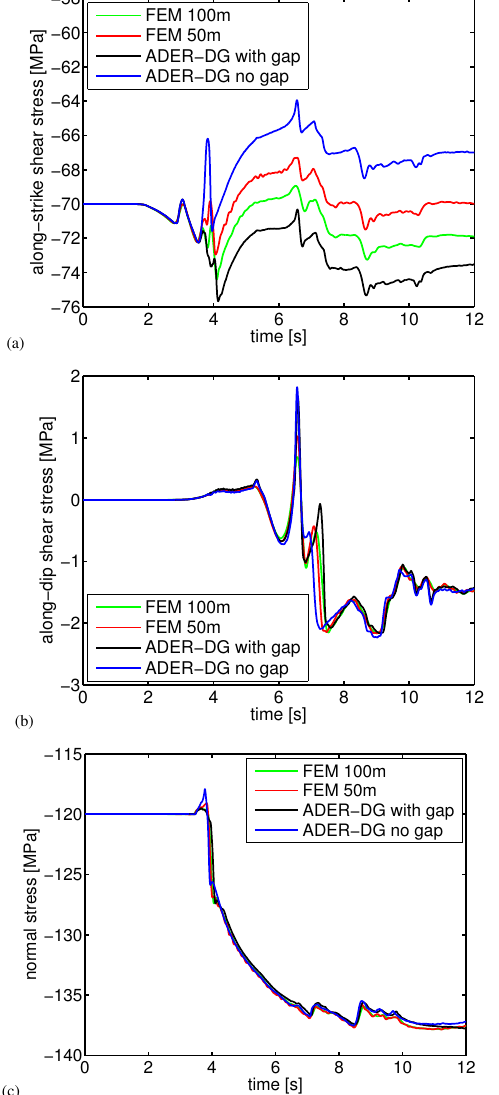
Table 4. Simulation parameters for SCEC test case TPV6.